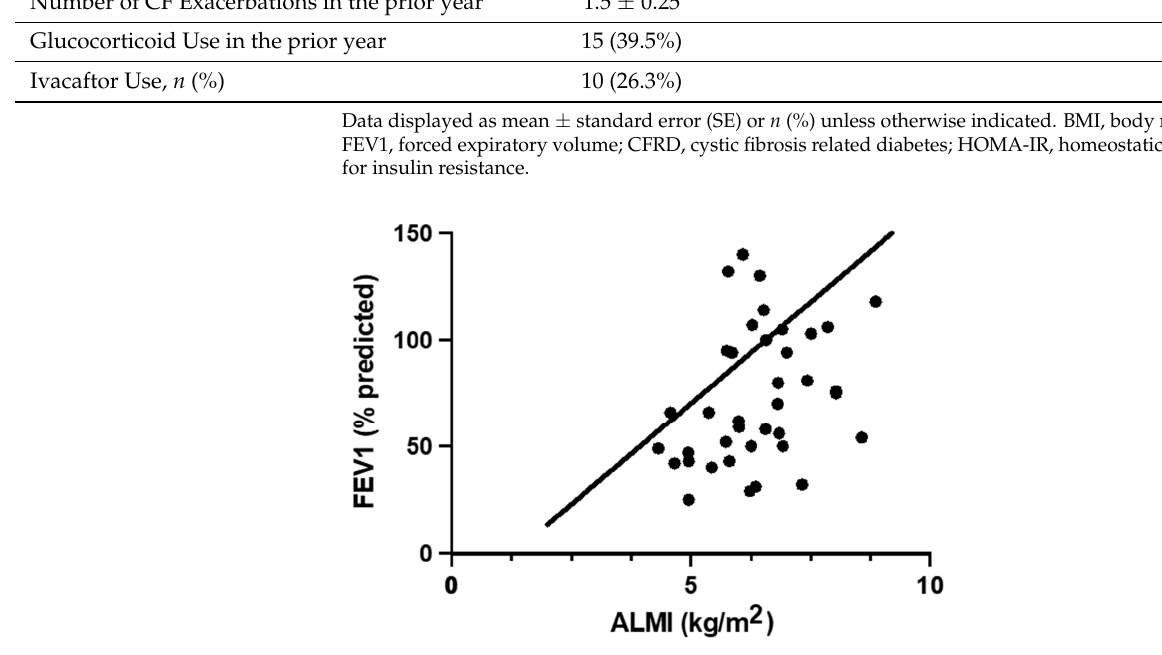
Figure 1. Multivariable regression of FEV1 vs. ALMI in participants with CF. Figure 1 displays the relationship between individuals’ FEV1 and ALMI values (circles) as well as the regression line of best fit across the whole dataset when controlling for age, gender and BMI (Model 2). FEV1, % predicted forced expiratory volume in 1 s; ALMI, appendicular lean mass index.